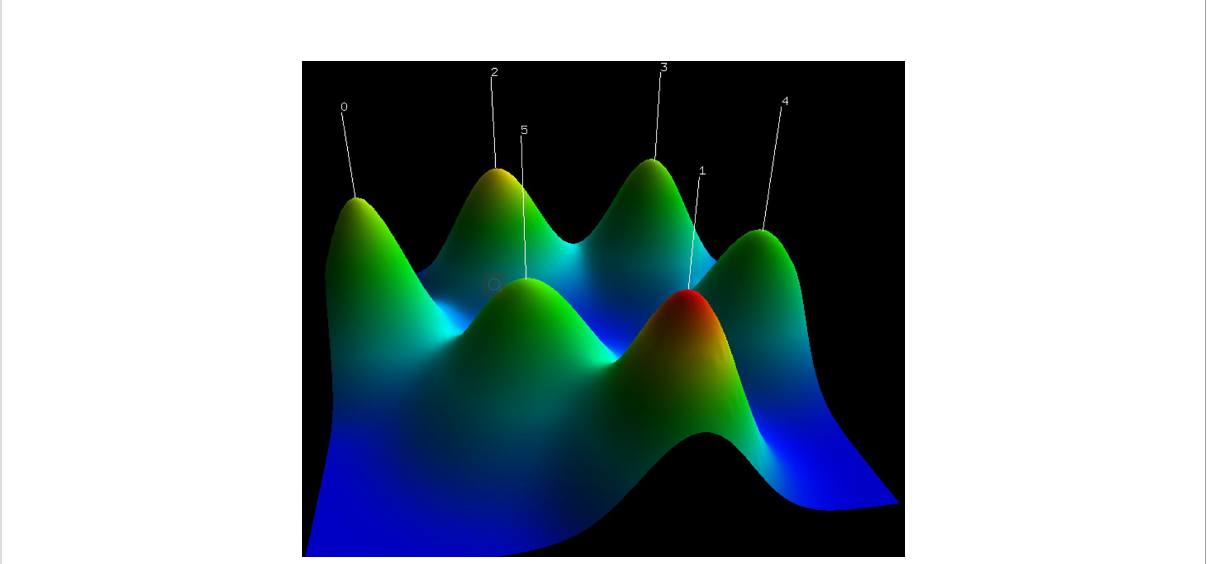
FIGURE 9 The visualized mountain map of the keywords: Cluster 0: Screening for breast cancer patients during the pandemic; Cluster 1: Breast cancer surgery in the pandemic; Cluster 2: Recovery of breast cancer patients during the pandemic; Cluster 3: Motion impact of the outbreak on breast cancer patients; Cluster 4: Diagnosis and treatment of breast cancer patients during the pandemic; Cluster 5: Clinical vaccine management of breast cancer patients during a pandemic.